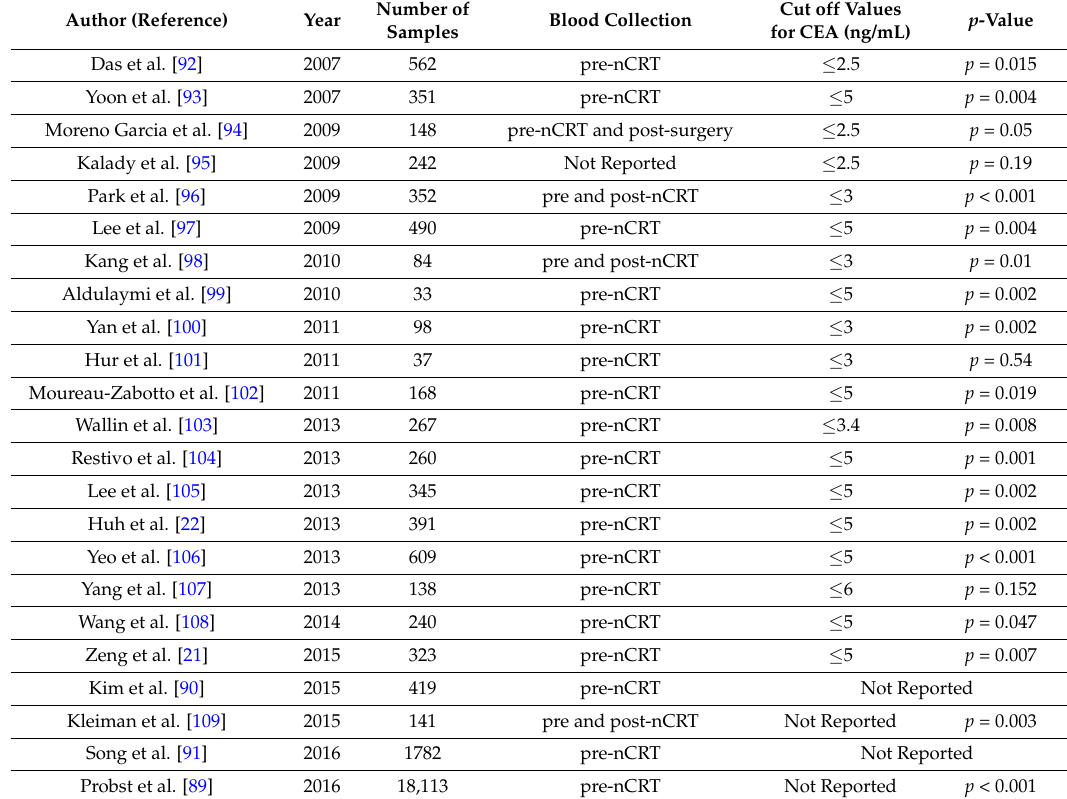
Table 2. Studies for CEA on the response to nCRT in rectal